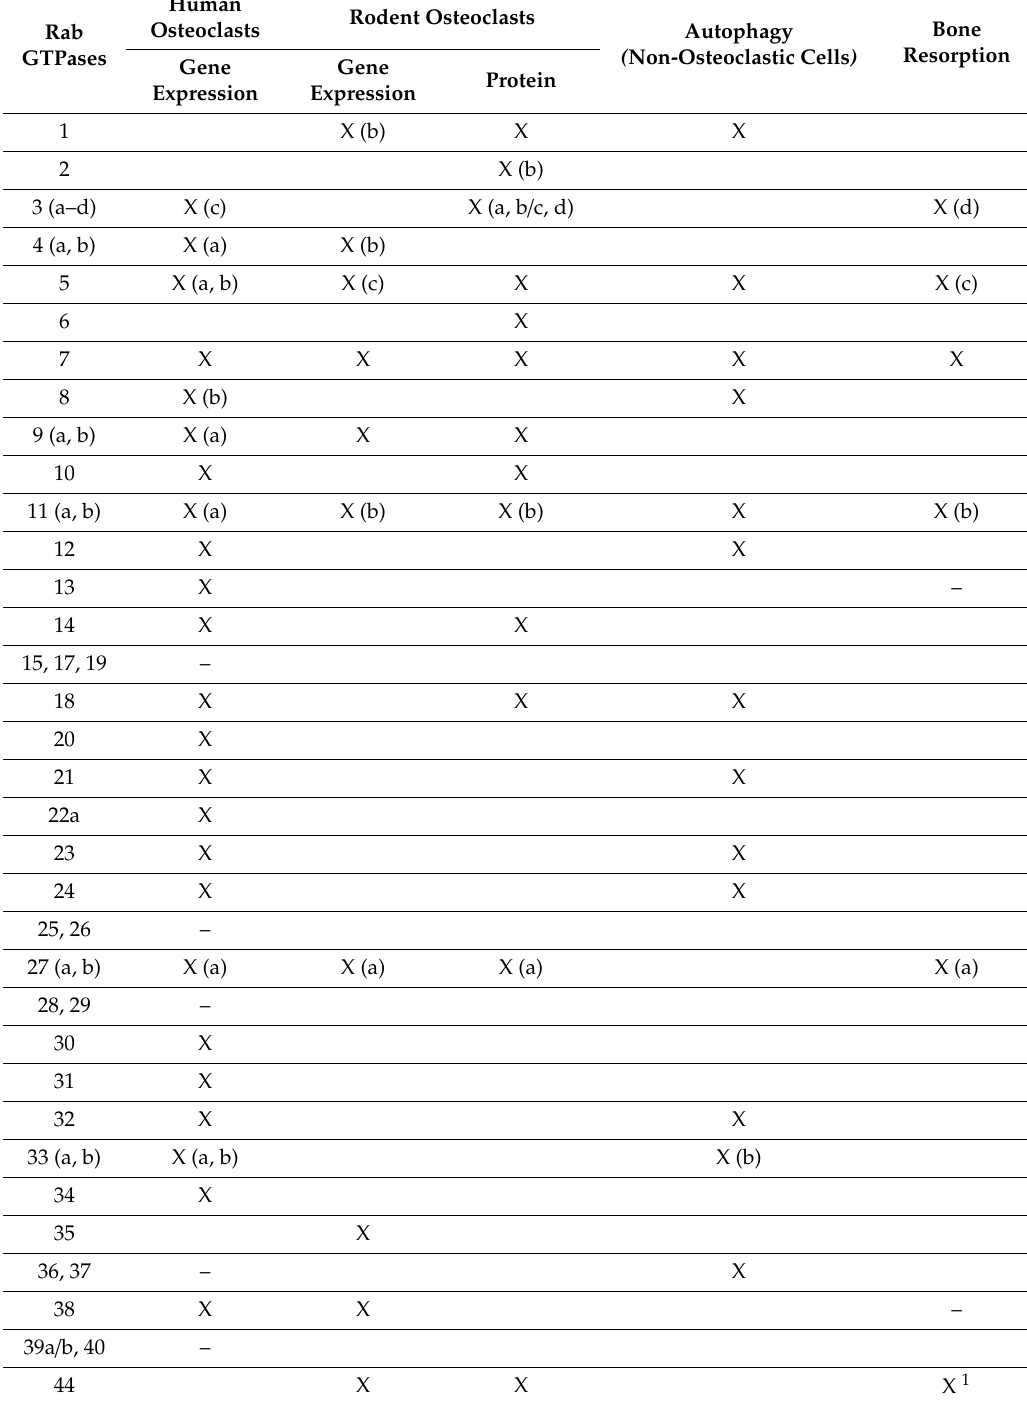
Bone Resorption